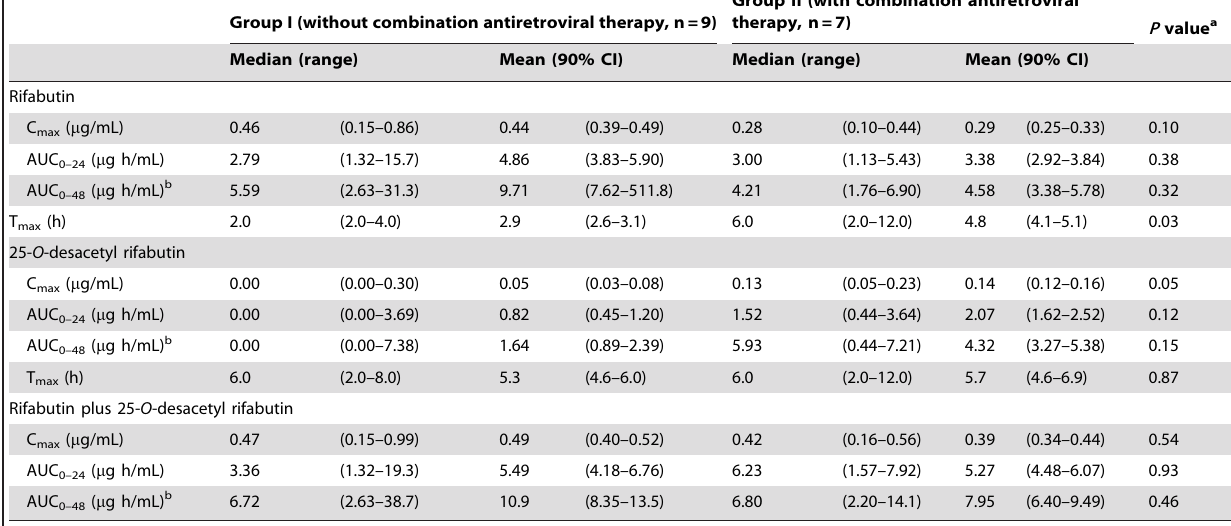
Group II (with combination antiretroviral therapy,